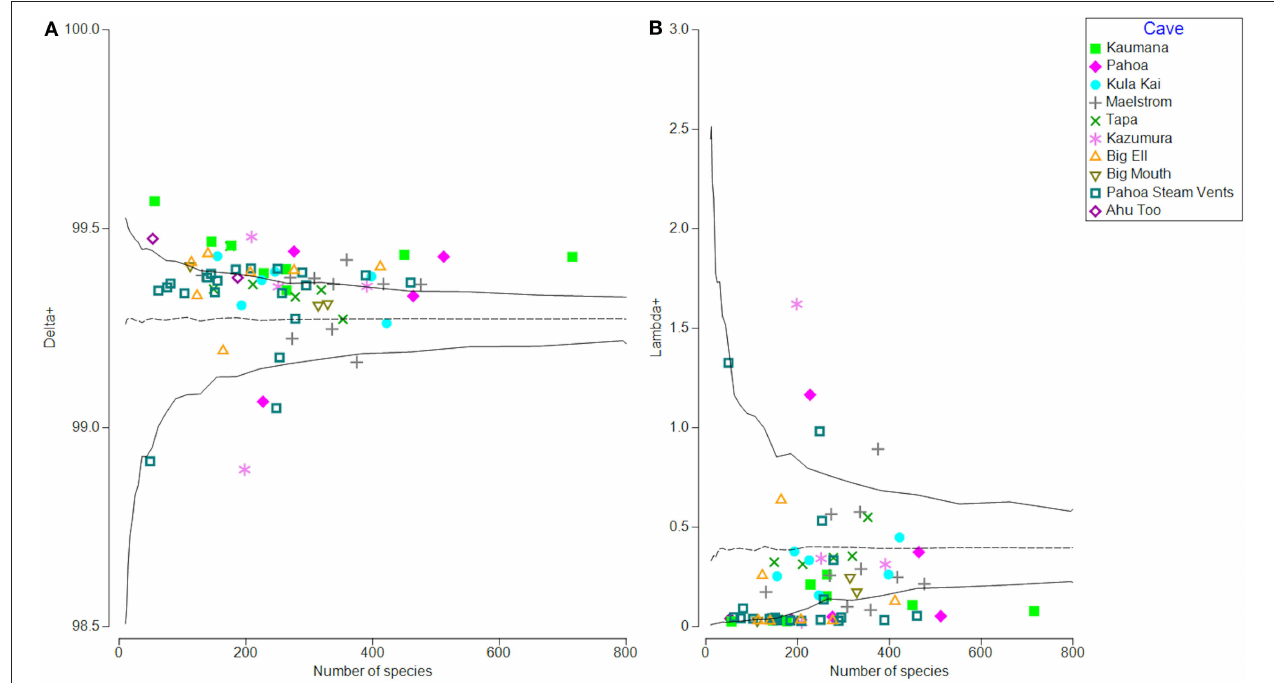
FIGURE 5 | Phylogenetic distinctness (Delta + ) on the left (A) and variation of phylogenetic distinctness (Lambda + ) on the right (B) for all samples based on patristic distances between identified taxa (ASVs). Samples are labeled by location. Most samples are either within expected values of Delta + (null = randomly distributed) or higher than expected, meaning samples are phylogenetically over-dispersed, possibly due to competitive exclusion (A) . Variation in phylogenetic distinctness (Lambda + ) is within expected values or lower than expected. Most samples had lower than expected variation in distances between branches on the phylogenetic tree, when compared to the null model of random assemblage, and represent that more distinctly related organisms are assembled into the community (B)